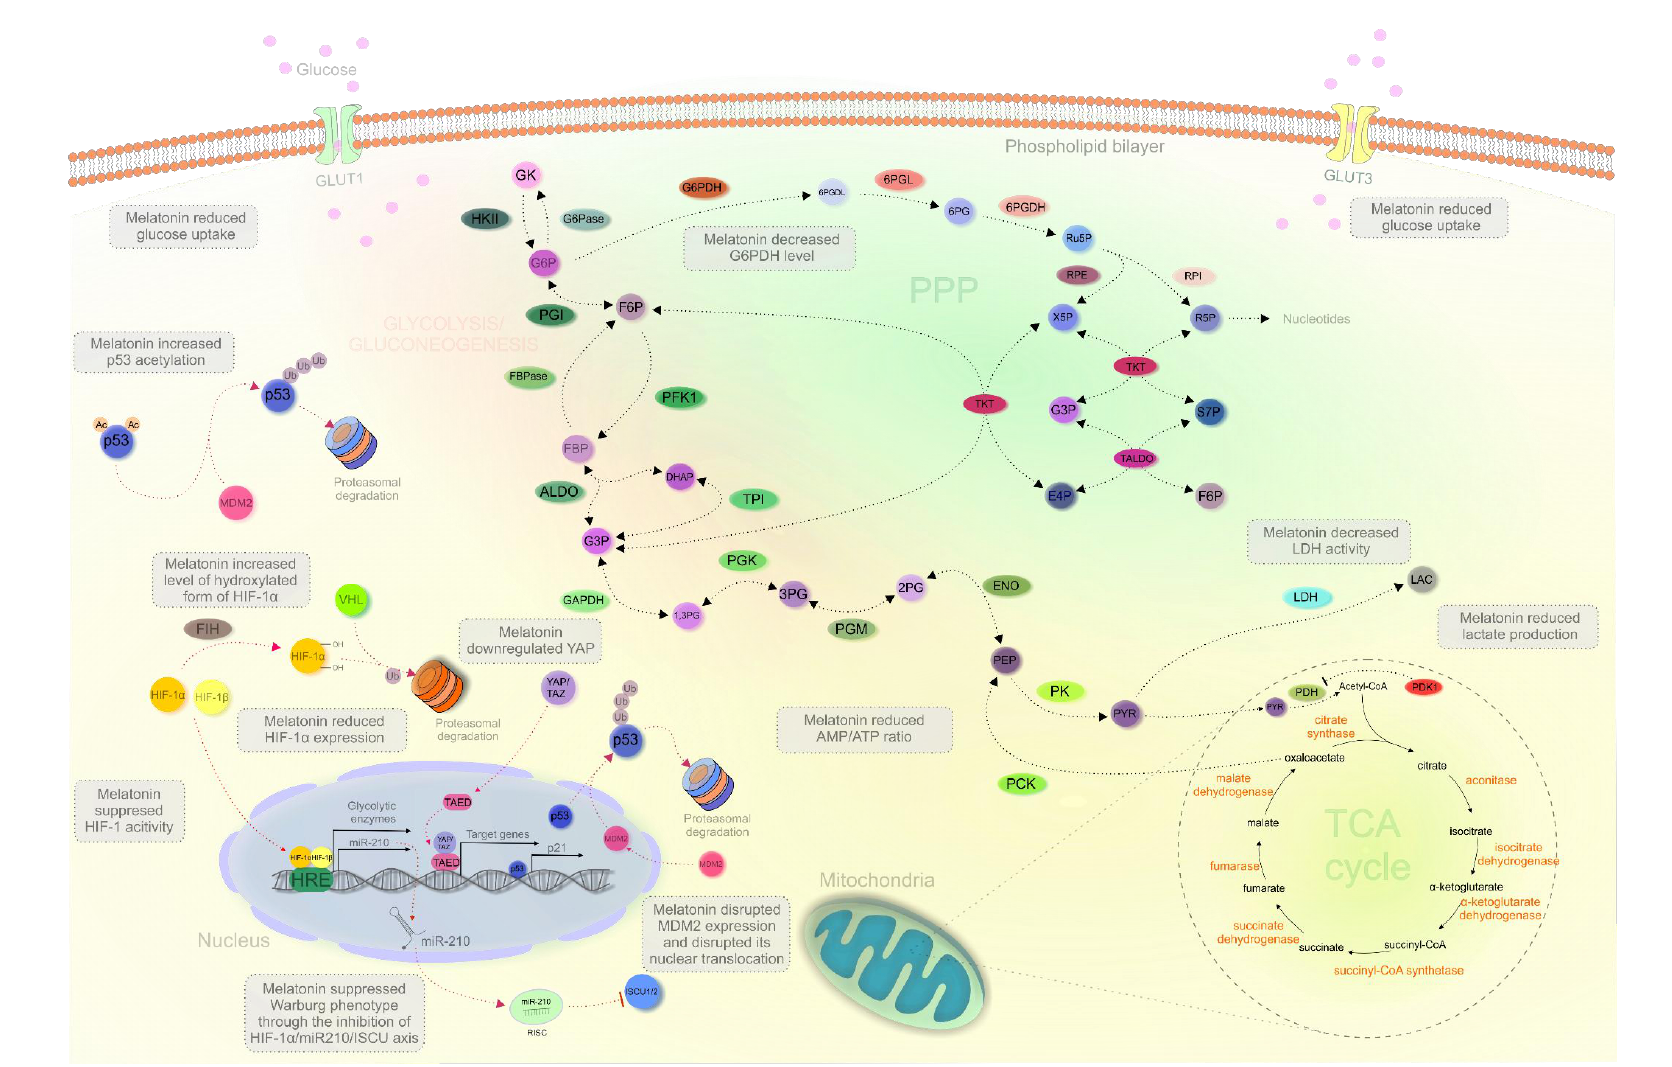
Figure 2. Melatonin targeting cancer metabolism. Abbreviations: GK, glucose; HKII, hexokinase II; G6P, glucose 6-phosphate; F6P, fructose 6-phosphate; PGI, phosphoglucose